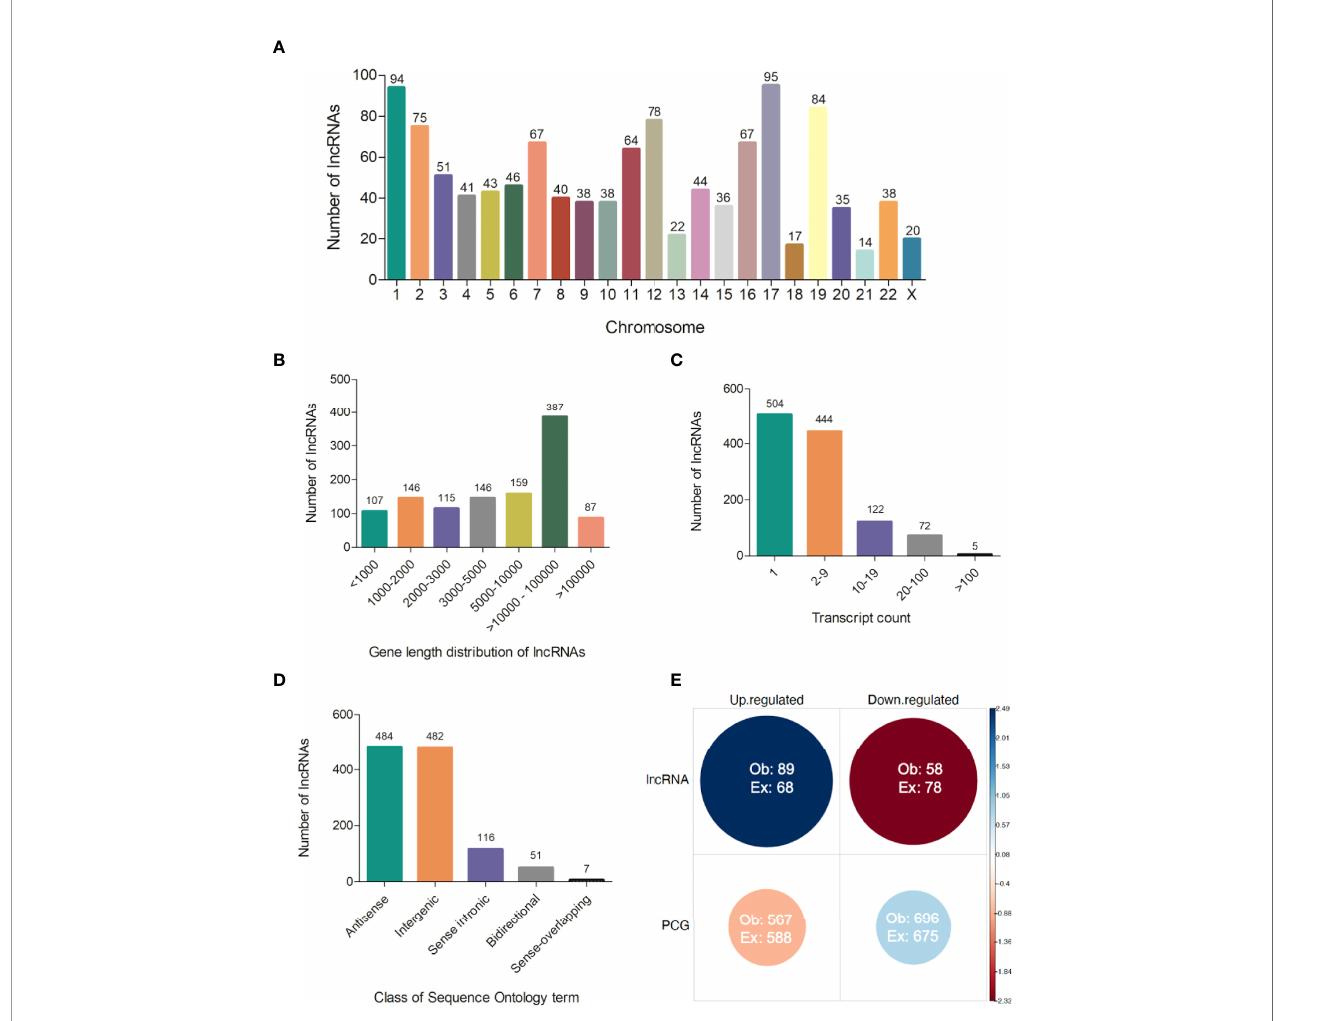
FIGURE 5 | Features of lncRNAs detected in polyadenylated RNA-seq of human visceral leishmaniasis. (A) Chromosomal distribution of lncRNAs across the 22 autosomes and the X chromosome; (B) Gene length distribution of lncRNAs; (C) Number of transcripts presented by each lncRNA; (D) Classi fi cation of lncRNAs according to sequence ontology terms; (E) Pearson ’ s chi-square test using the number of lncRNAs and protein-coding genes (PCGs) and regulation patterns (up- or downregulated transcripts) in DEG datasets (comparisons of non-diseased groups, A, C and PD180 to PD0 active VL). The size and color intensity of circles are proportional to the contribution of the cell to the signi fi cance of the chi-square test. The standardized residuals are scaled at the sidebar, where positive and negative values indicate positive and negative associations, respectively. Ob, observed value; Ex, expected value, c 2 = 12.343, df = 1, p-value =